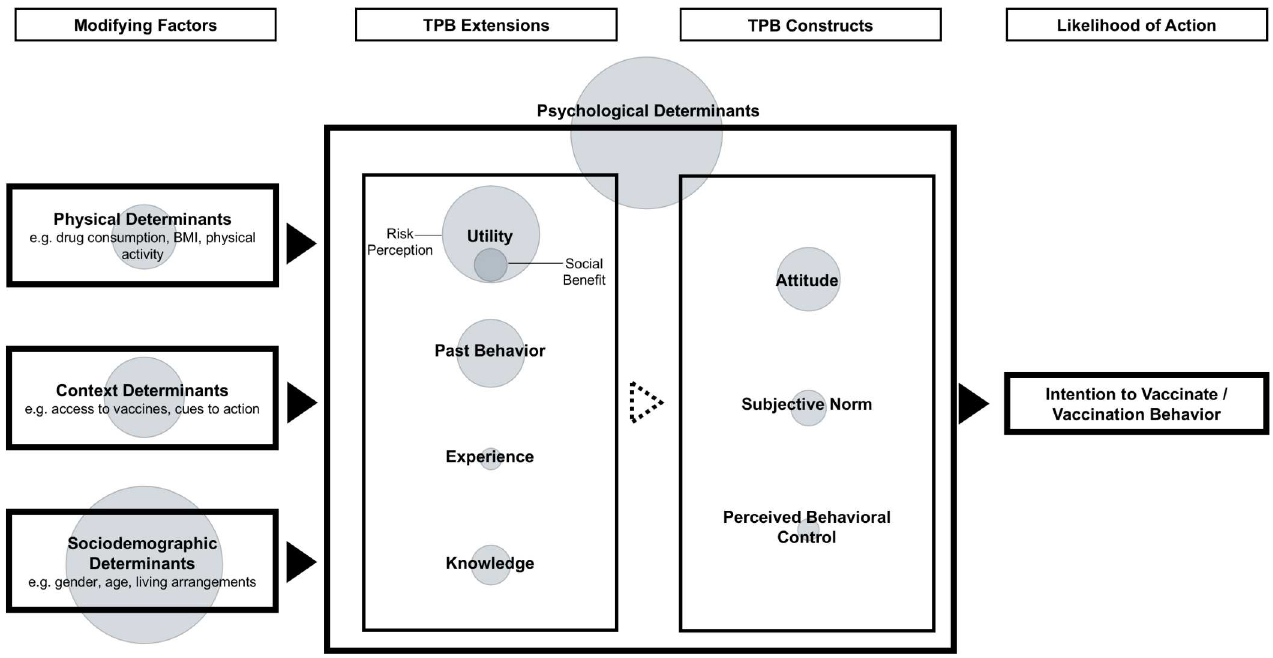
Fig 1. Micro-level determinants of vaccine hesitancy following an extended version of the Theory of Planned Behavior (TPB). Determinants are basedon empiricaland theoreticalwork from Ajzen [23], Schmiegeet al. [25], Rhodes& Courneya[26], Koo et al. [27], Pomery et al. [28], Larson et al. [10]. Significantdeterminants from 470 research articles are clusteredaccordingto the model. Circle size represents the total numberof